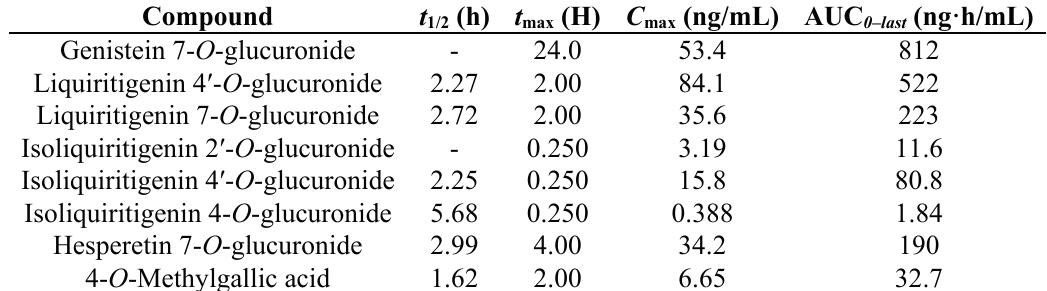
Table 2. Pharmacokinetic parameters of flavonoid glucuronides and 4- O -methylgallic acid.